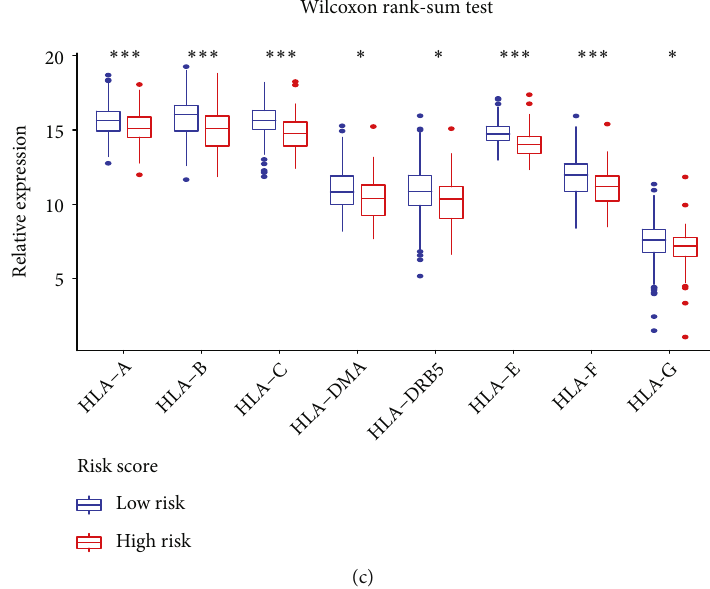
Figure 10: Immune landscape analysis. (a, b) Relative enrichment scores of immune cell in fi ltration in the TCGA-LIHC dataset (a) and GSE14520 dataset (b). (c) Di ff erential expression of HLA genes in the high- and low-risk groups. Wilcoxon rank-sum test, ∗ P < 0 : 05 , ∗∗ P < 0 : 01 , and ∗∗∗ P < 0 : 001